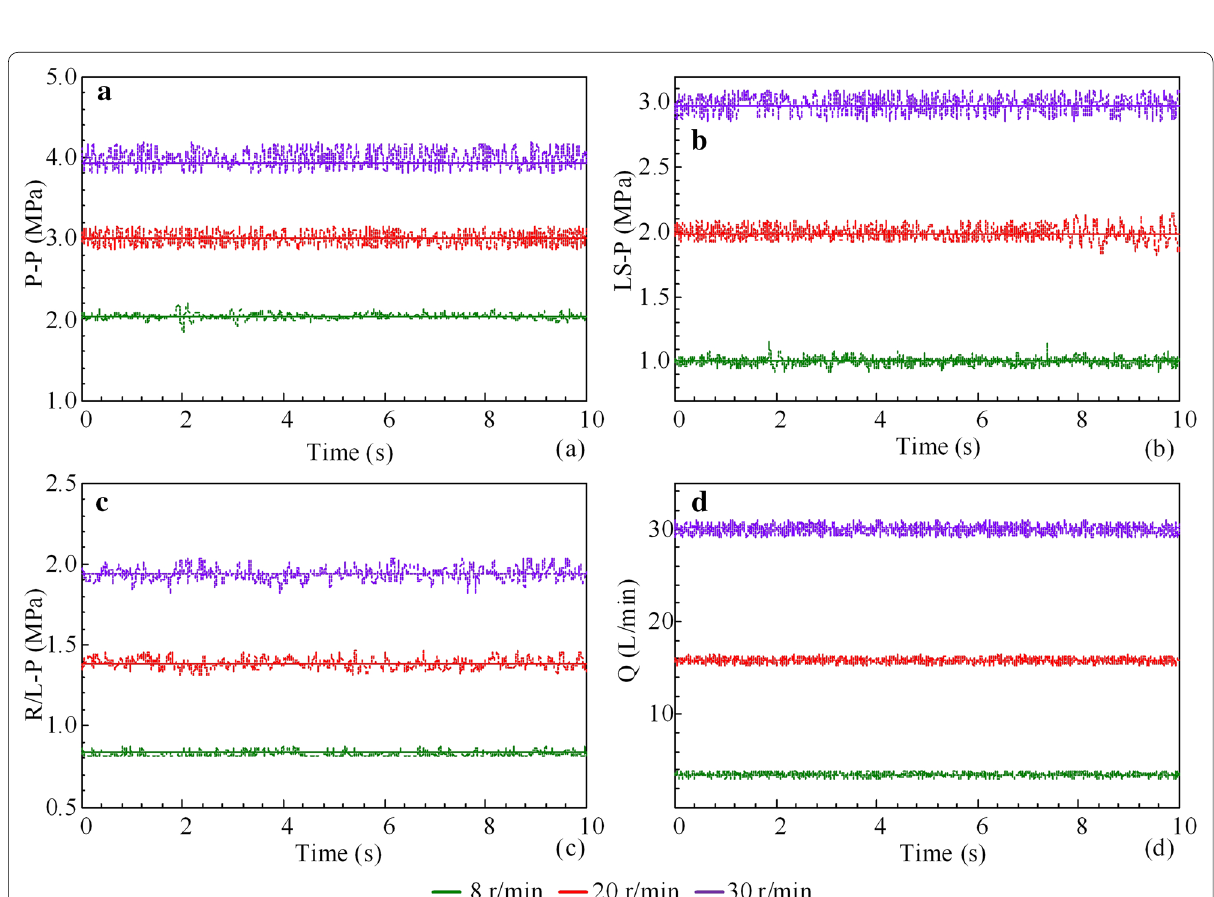
Figure 12 Experimental results under no load condition and electromotor speed of 708 r/min: a P , b P LS , c P R / L , and d